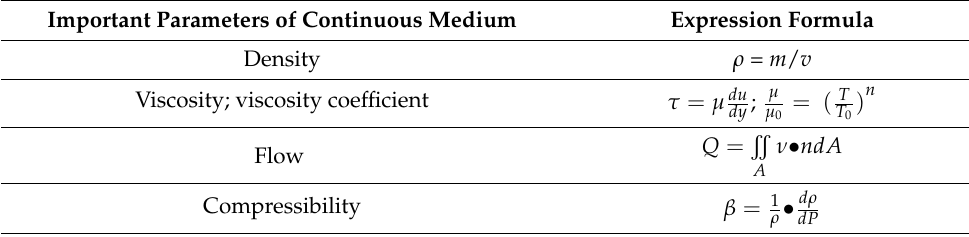
Table 1. Important parameters and expression